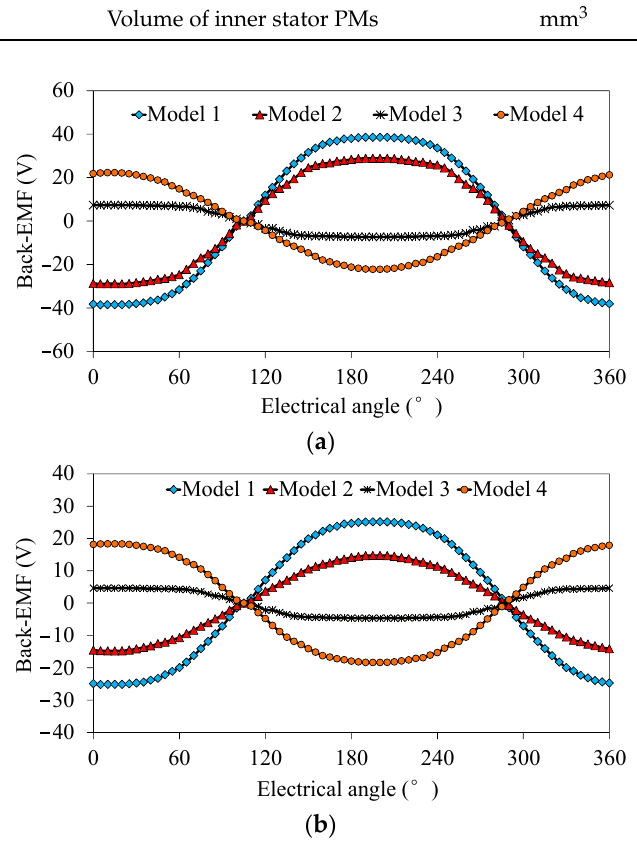
Figure 5. Back-electromotive force (EMF) waveforms in phase A of four magnetization patterns. ( a ) Primary windings; ( b ) secondary windings.